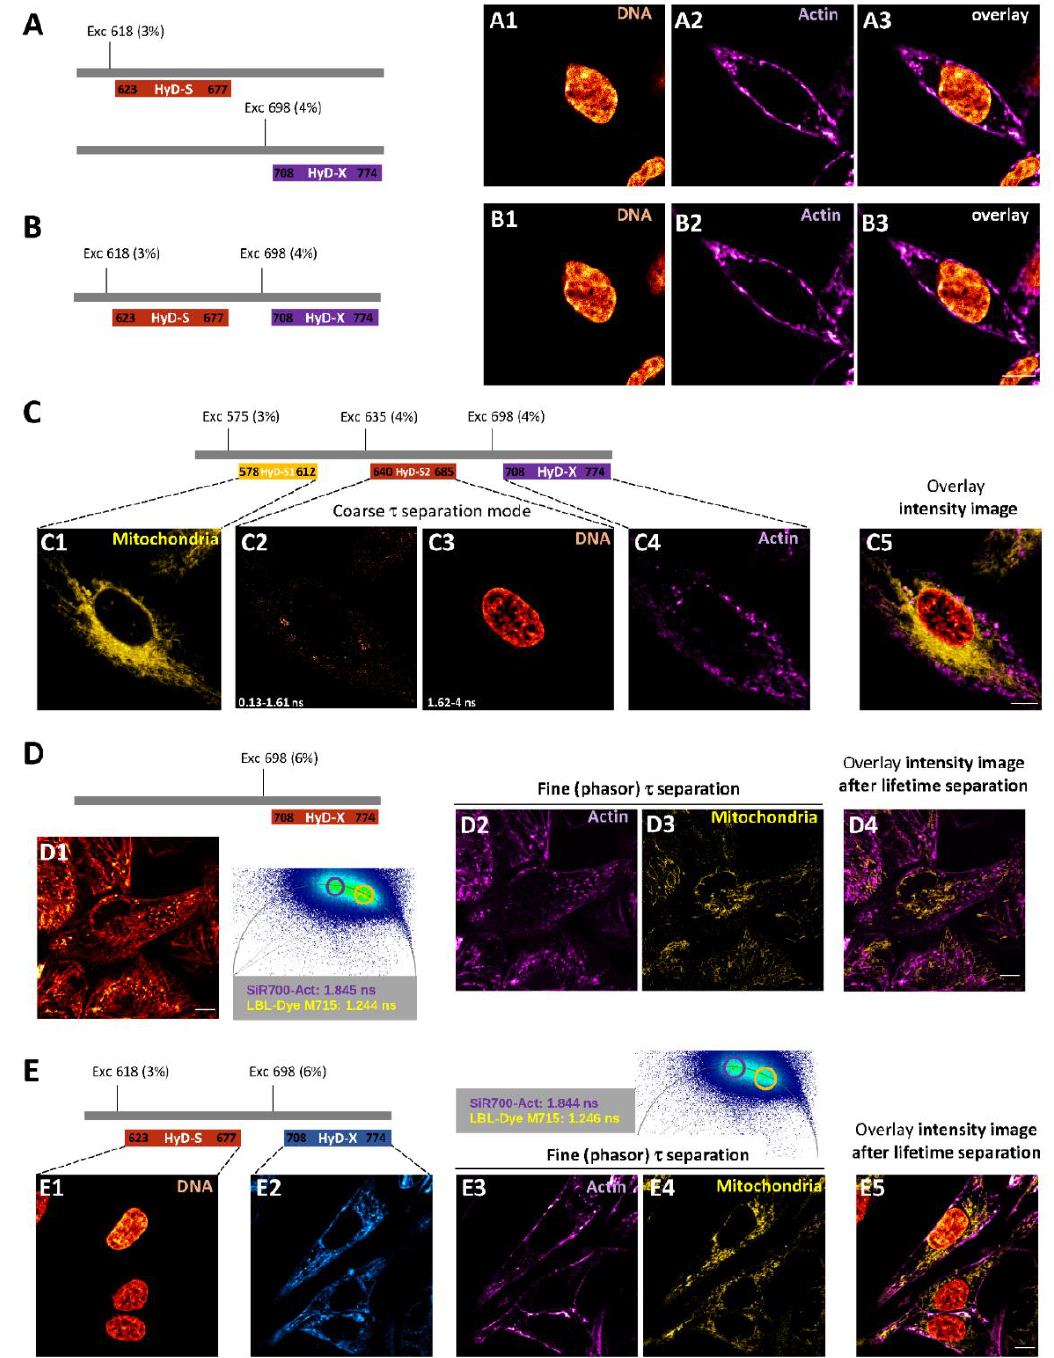
Figure 4. Input of coarse and fine fluorescence lifetime ( τ ) separation in organic red/near-infrared multiplexing with living H28 cells. Confocal imaging of H28 living cells stained with SPY620-DNA (red hot) and SiR700-Actin (magenta hot) in sequential ( A ) or simultaneous ( B ) mode. ( C ) Confocal imaging of triple-stained H28 cells in simultaneous mode. MitoTracker red (ex 594 nm—HyD-S1; ( C1 )), SPY620-DNA dye (ex 618 nm—HyD-S2; ( C2 , C3 )) with coarse τ separation and SiR700-Actin dye (exc 698 nm—HyD-X; ( C4 )). ( D1 ) Confocal imaging of H28 living cells stained with SiR700-Actin and LBL-Dye M715. ( D2,D3 ) Fine τ separation of fluorescence lifetime components through phasor plot analysis after activation of FAst Lifetime CONtrast (FALCON) module and overlay of resulting imaging ( D4 ). ( E ) Confocal imaging of triple-stained H28 cells in simultaneous mode. SPY620-DNA (ex 618 nm—HyD-S; ( E1 )) and SiR700-Actin with LBL-Dye M715 (ex 698 nm—HyD-X; ( E2 )) with fine τ separation through phasor plot analysis after activation of FALCON module ( E3 , E4 ) and overlay of resulting imaging ( E5 ). Scale bars 10 µm.